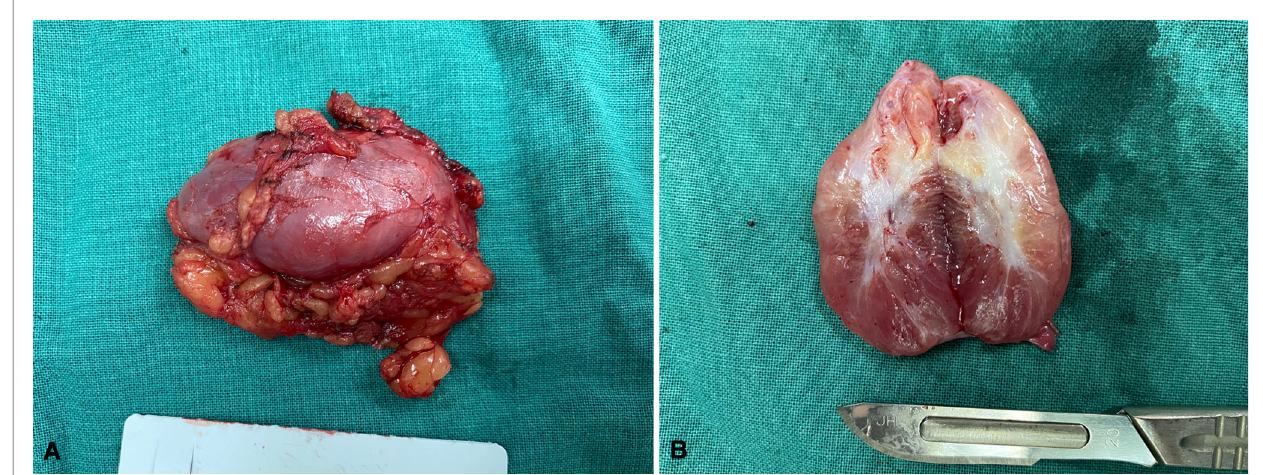
FIGURE 1 | The macroscopic appearance and cut surface. ( A ) The surface of the tumor, ( B )The cut surface of the